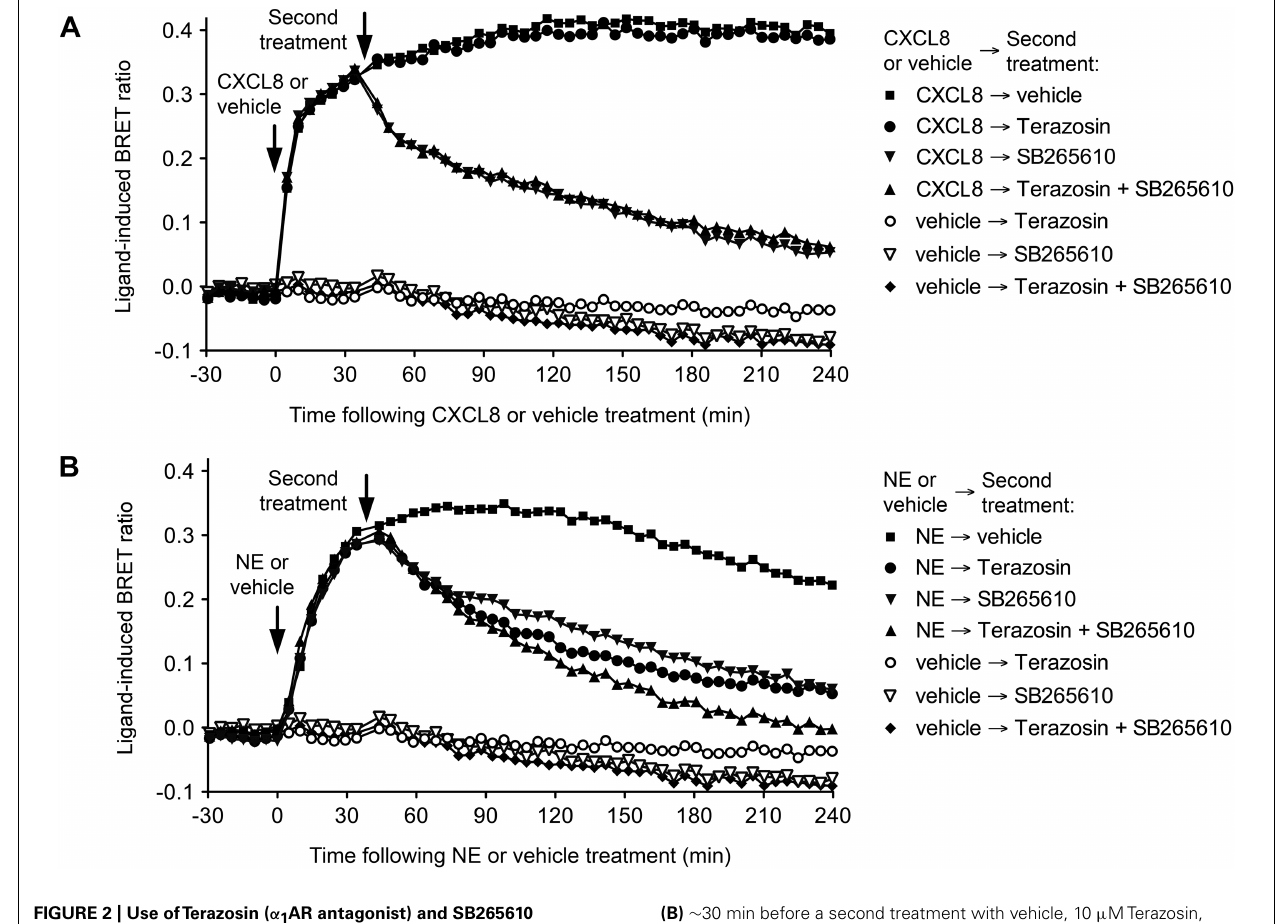
FIGURE 2 | Use ofTerazosin ( α 1 AR antagonist) and SB265610 (CXCR2 inverse agonist) to interrogate β -arrestin2 recruitment to the α 1A AR-CXCR2 heteromer. Extended BRET kinetic profiles were generated for the CXCR2/Rluc8, β -arrestin2/Venus and α 1A AR combination in HEK293FT cells by treating with CXCL8 or vehicle (A) or NE or vehicle